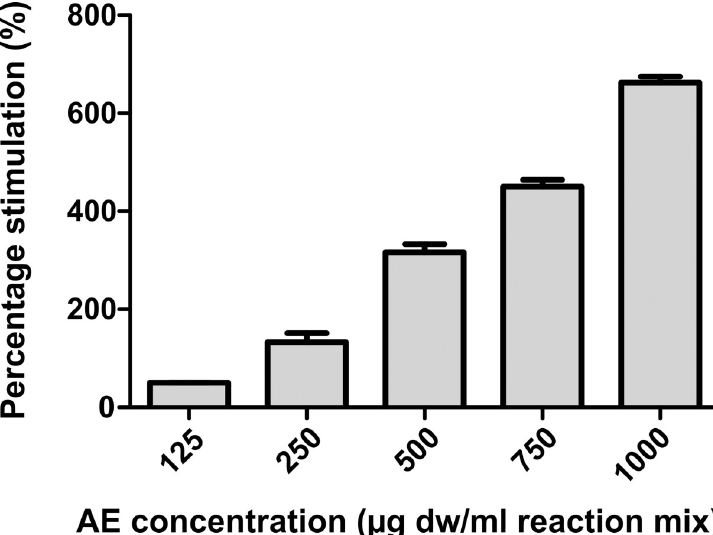
Fig 3. Percentage of stimulation of nucleation produced by C . officinarum AE. Results are the mean ± SD of more than 3 different experiments. The median of each sample differs from the others (p < 0.05) as inferred by the Kruskal Wallis test followed by Dunn’s post